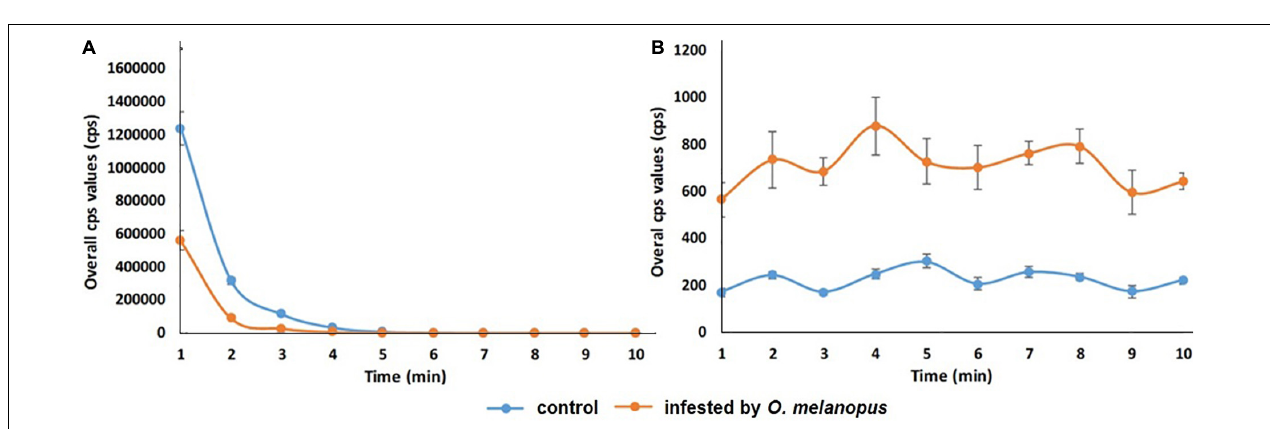
FIGURE 6 | Sum of overall count per second (A) DF and (B) UPE values of control and O. melanopus -infested wheat. Mean values ( n = 3) and standard deviations are presented. Letters represent significant differences within the treatments.